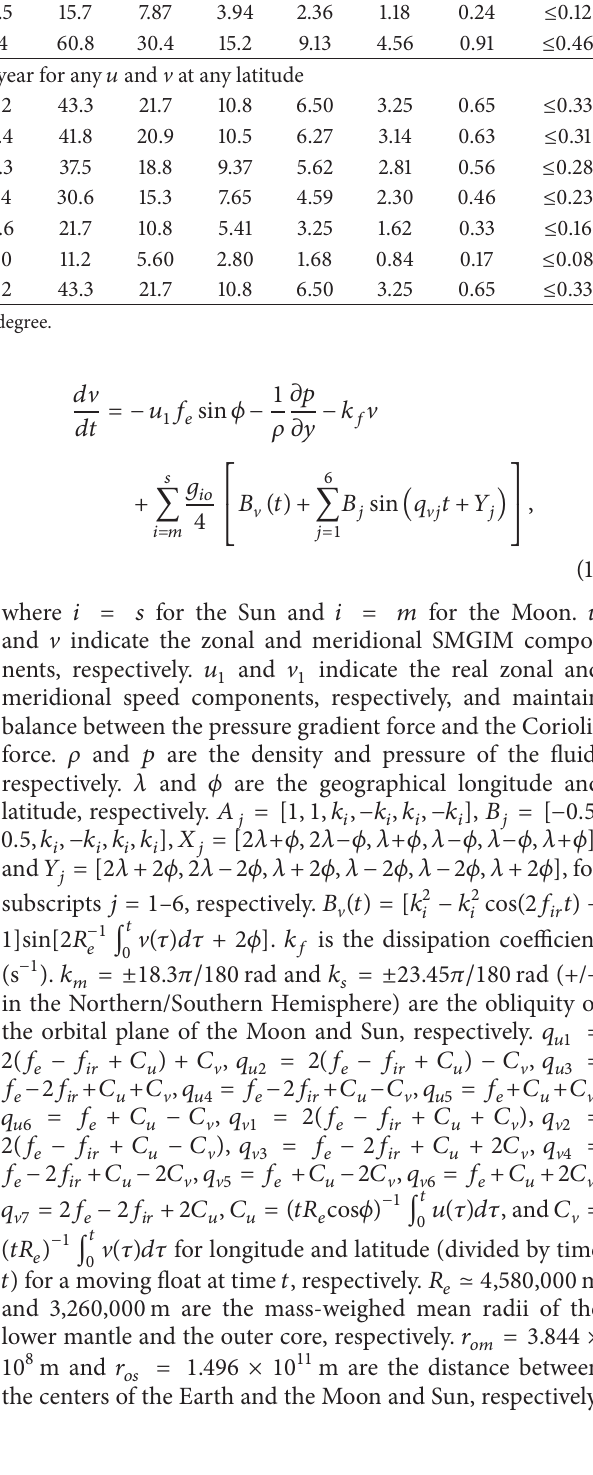
Under the gravitation of the Moon